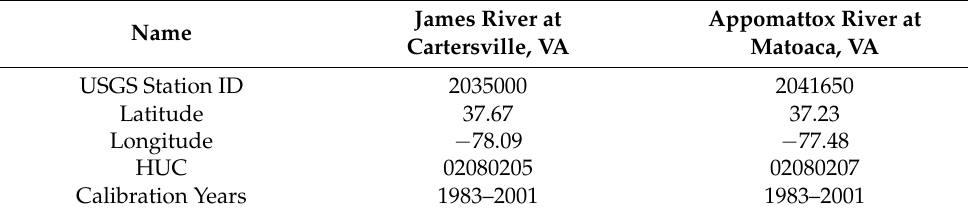
Table 1. Locations of calibration sites within the James River, Virginia, watershed